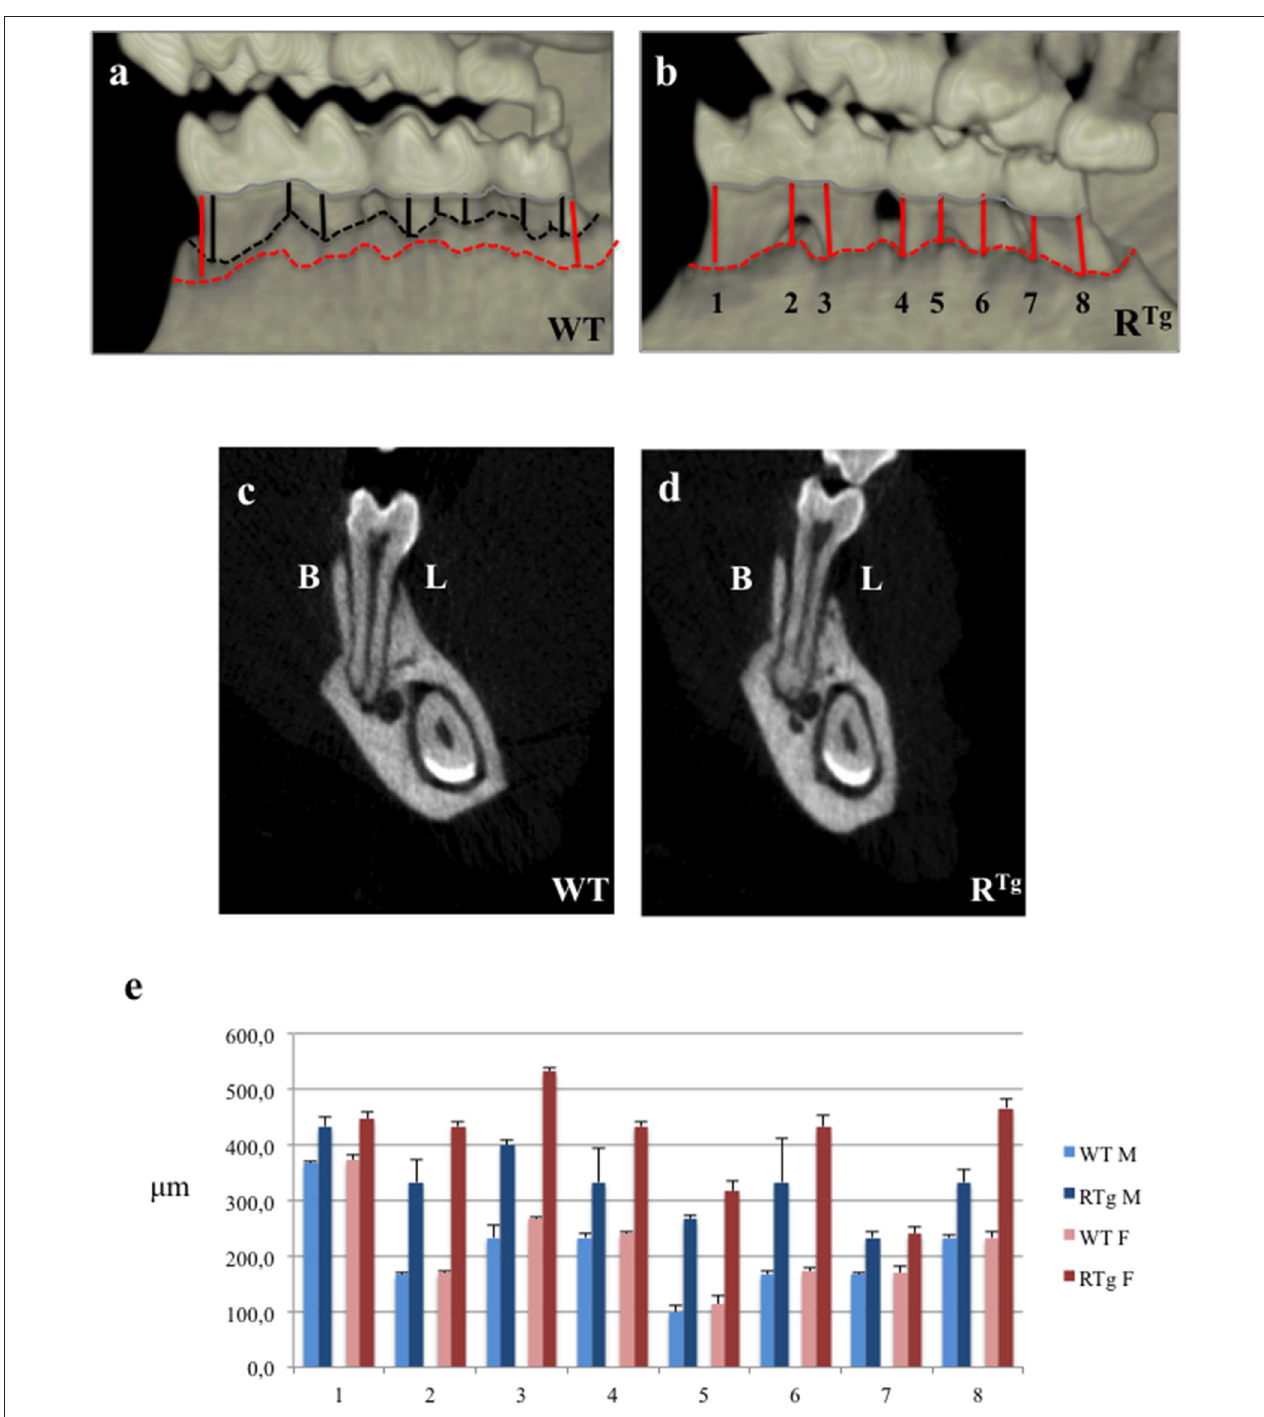
FIGURE 1 | Micro-Computed-Tomography (micro-CT) analysis of alveolar bone height in 5-month-old mice. Distances between the cervical enamel and alveolar bone crest of the mandible were measured for each molar in eight positions (black lines for WT mice, and red lines for R Tg mice). We observed a loss in height in R Tg mice relative to WT mice, in the interproximal and inter-radicular areas (a,b) , as well as the buccal (B) and lingual (L) alveolar crests in frontal sections (c,d) . The mean distances between alveolar bone crest and cervical enamel ( µ m) were measured in eight different areas (e) . Statistical analyses showed significant differences ( p < 0.01), with greater bone loss in R Tg mice ( n = 10), which was greater in transgenic females ( n = 5).